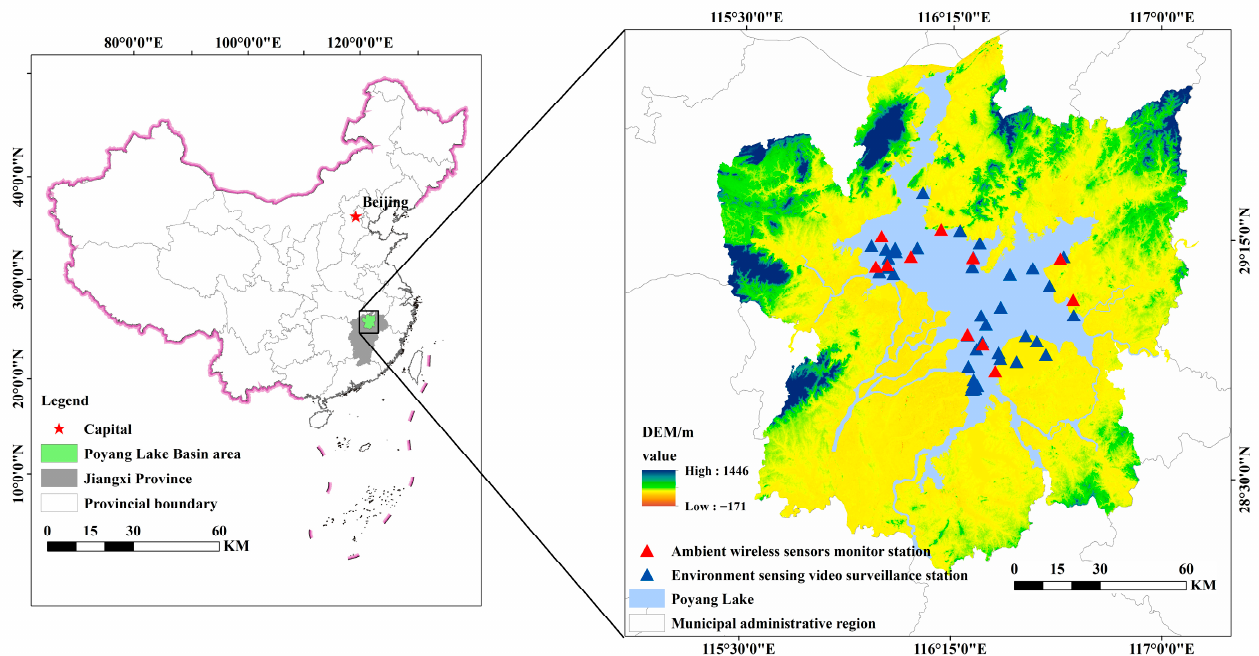
Figure 4. Distribution of environmental sensing sites.